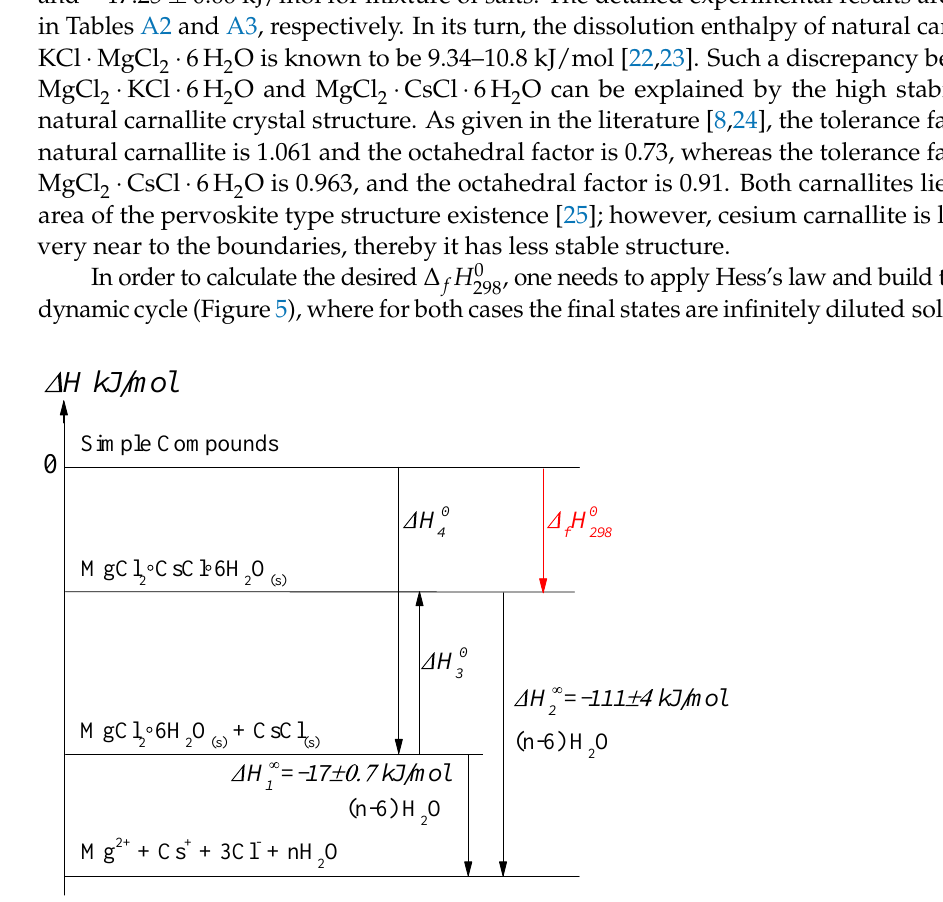
Figure 5. Thermochemical cycle for MgCl